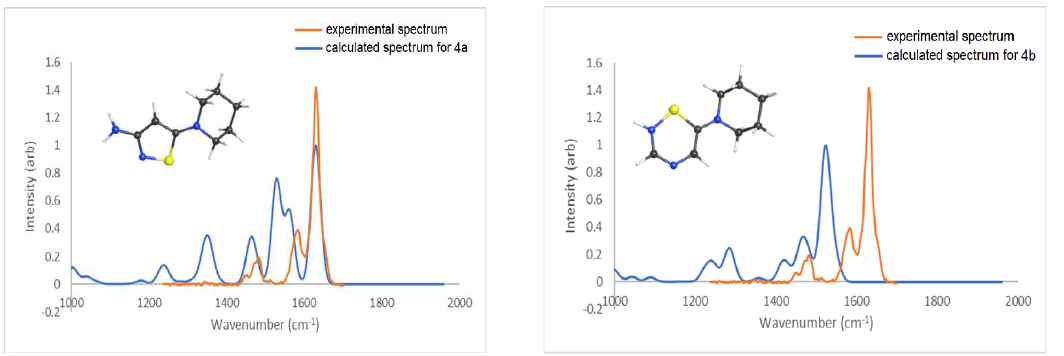
Figure 5. Calculated (blue trace) IR spectra (B3LYP/6-311+g(d,p)) for 4a (0.0 kJ/mol) and 4b (84.5 kJ/mol) vs. experimental (orange trace) IRMPD spectrum of the ion m / z 183.